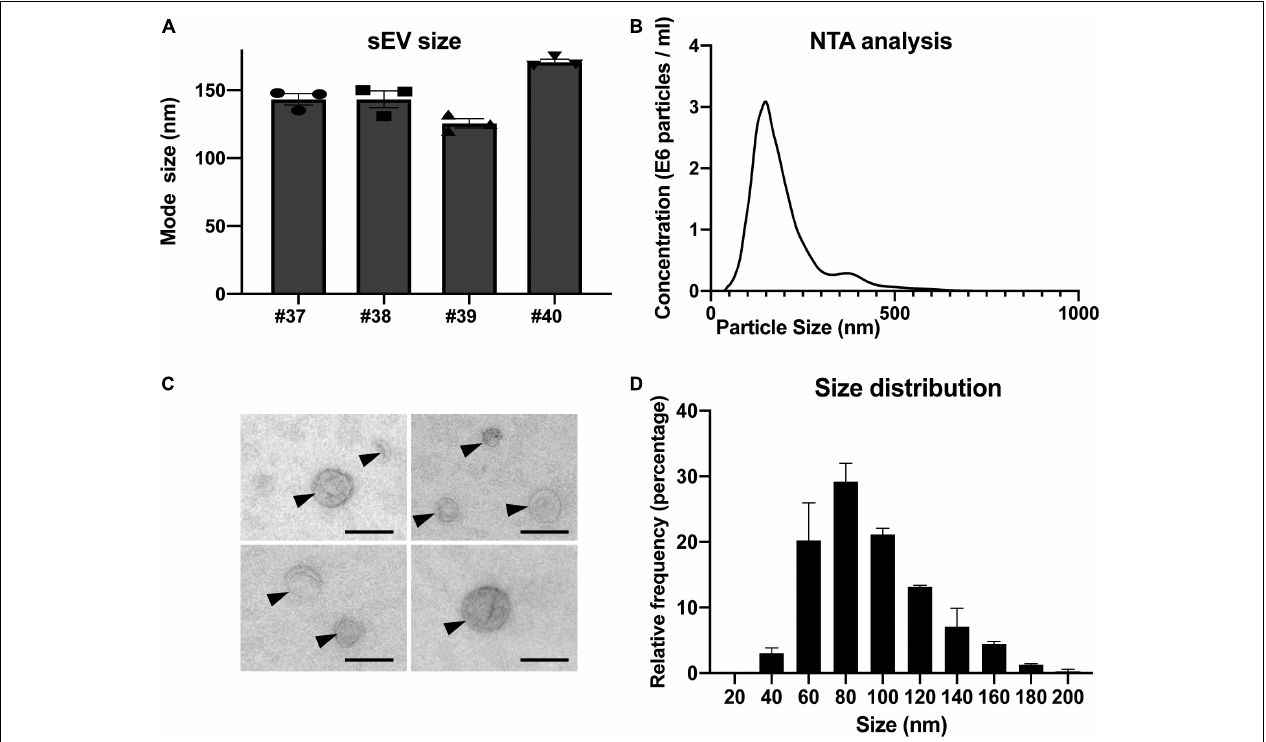
FIGURE 3 | Nanoparticle tracking analysis and electron microscopy characterization of sEV prepared from placental explants. (A) Individual analyses of mode size (nm) of four independent placental sEV preparations by nanoparticle tracking analysis. Histograms represent mean ± SEM of three independent measurements (represented by individual dots) for each preparation. (B) One representative nanoparticle tracking analysis. (C) Placental sEVs observed by TEM of two independent experiments. sEVs are indicated by black arrows. Scale bar = 100 nm. (D) Frequency distribution analysis of placental sEV size. Each bar of the histogram represents the mean ± SEM of the relative frequency per bin (bin width = 20 nm) of two independent experiments. Total sEV count was 172 and 208 for each sEV preparation, respectively.